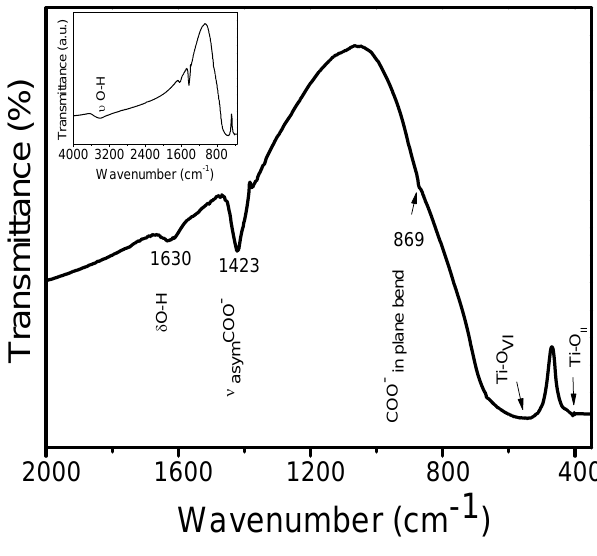
Figure 3. Raman spectra of BaTiO